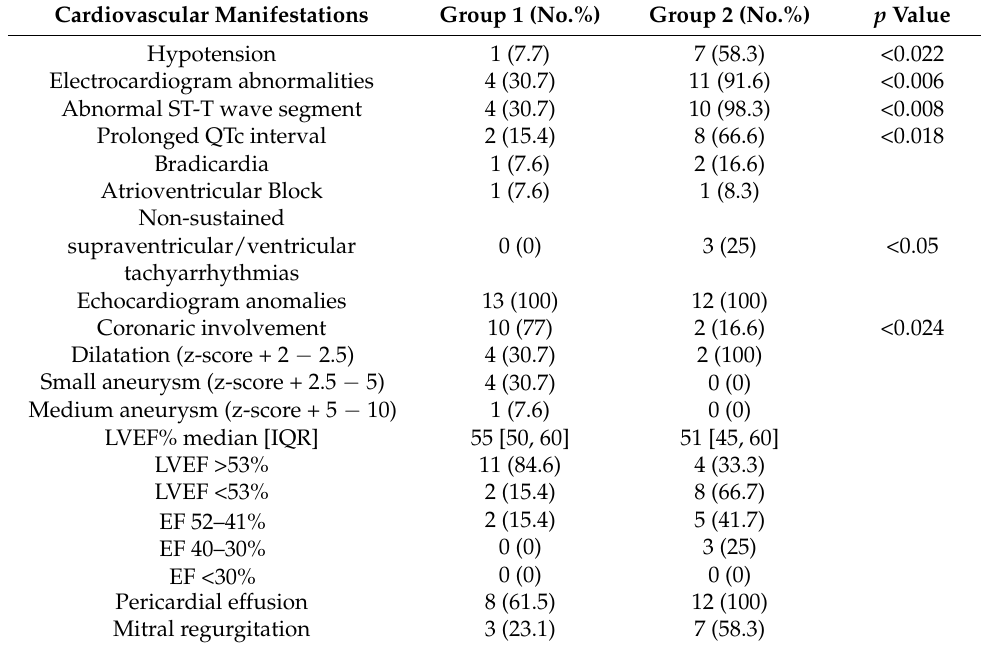
Table 4. Detailed cardiovascular manifestations comparing different age groups. Group 1: <6 years old (No.13); group 2: ≥ 6 years old (No.12). Reported only significant p values (<0.05). MIS-C: multisystem inflammatory syndrome in